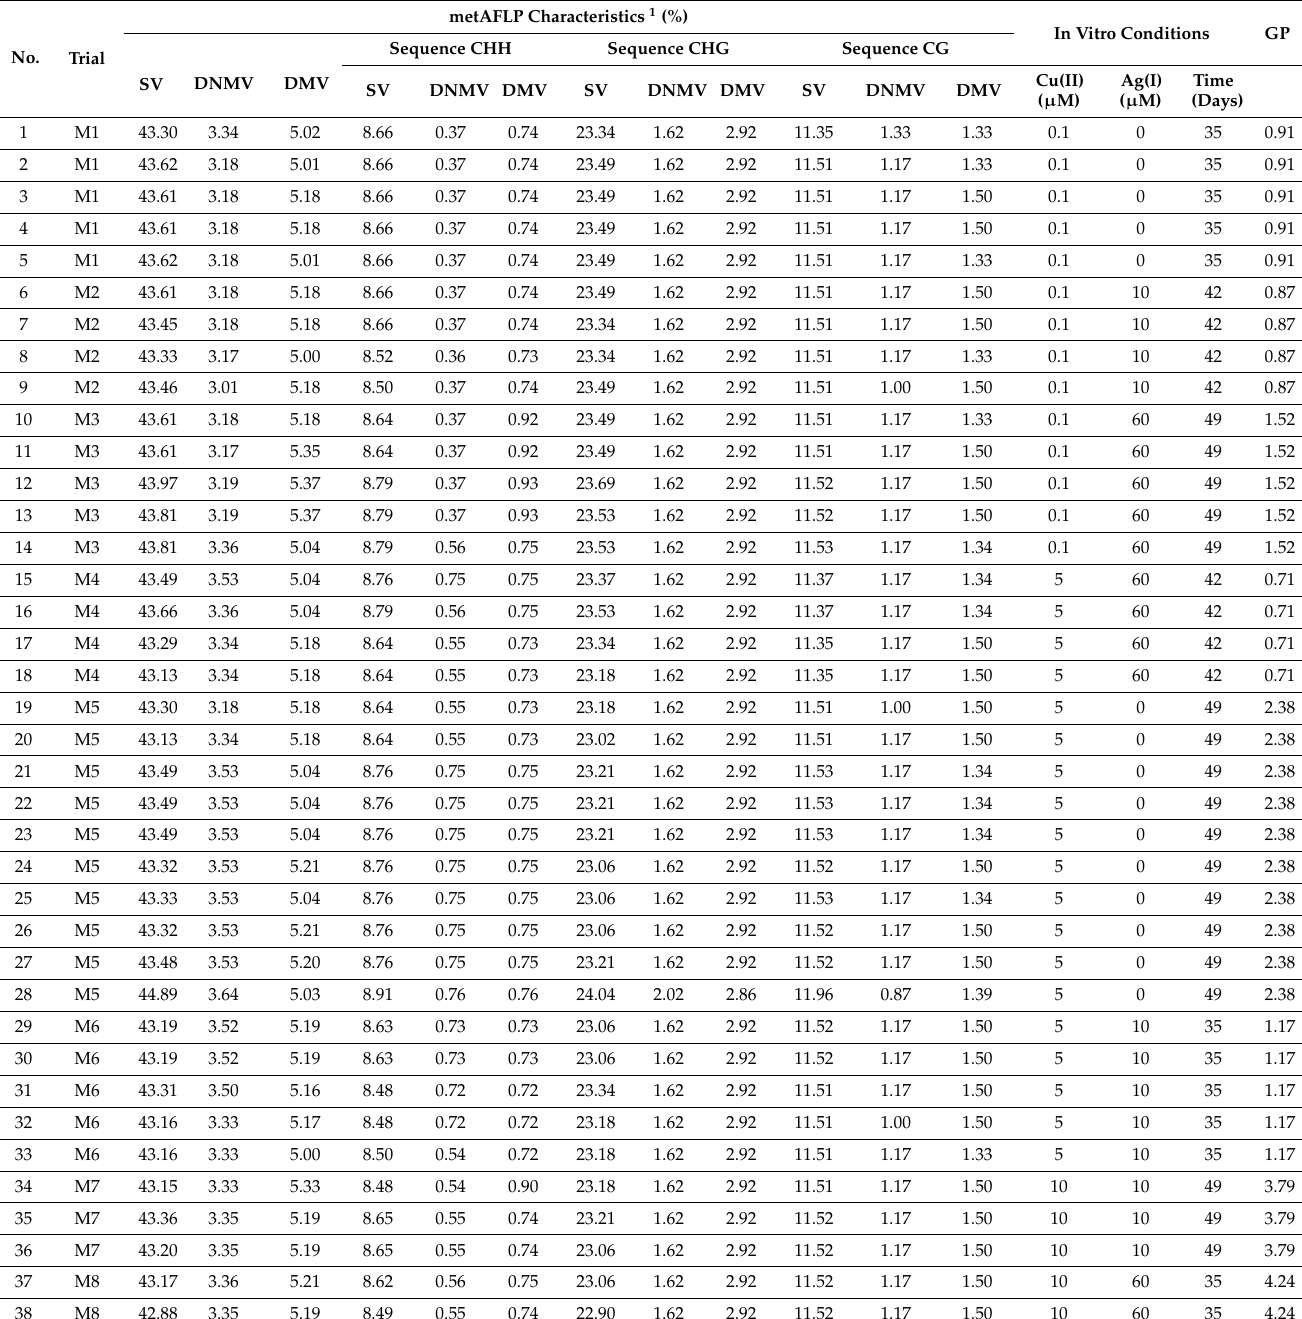
Table 1. Quantitative metAFLP characteristics and respective tissue culture conditions used for DH plant regeneration by trials